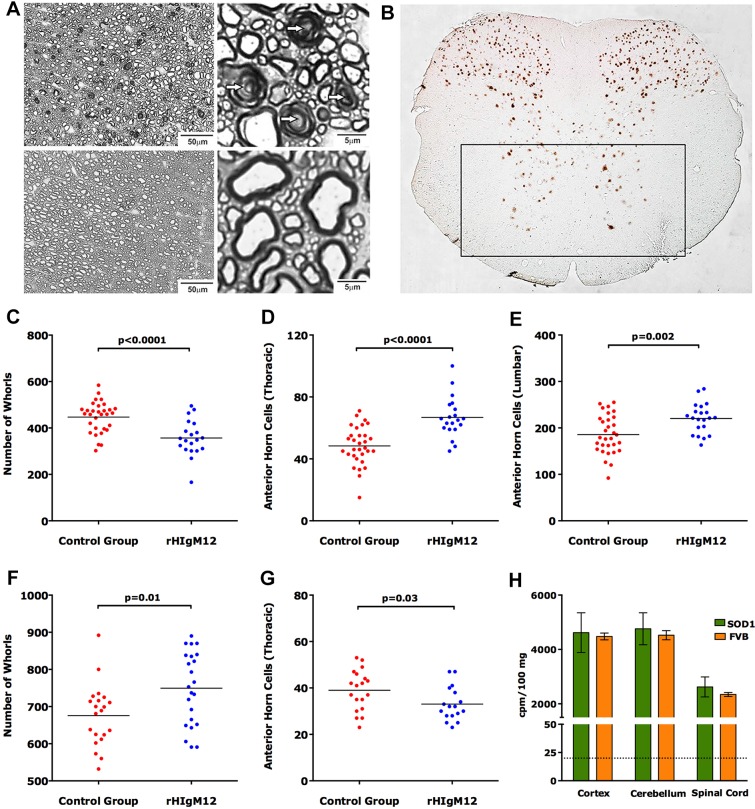
A single 200 µg dose of rHIgM12 preserves spinal cord neurons in SOD1G86R mice. Spinal cord axonal injury and motor neuron loss was examined histologically. Myelin whorls, characteristic of degenerating axons, were counted in six sampled areas from a mid-thoracic spinal cord section. (A) Representative mid-thoracic-level micrographs from a SOD1G86R mouse containing numerous myelin whorls (upper panels; arrows) compared to micrographs from an age-matched normal littermate control (lower panels). An analysis of the number of myelin whorls indicated fewer degenerating axons in rHIgM12-treated SOD1G86R mice compared to controls (C, P<0.0001, t-test). However, this was not true of rHIgM12-treated SOD1G93A mice (F, P=0.01). (B) Because human ALS primarily affects the health of motor neurons, anterior horn cells of the spinal cord (outlined in the black rectangle) were quantified across treatment groups. Two mid-thoracic- and two lumbar-level spinal-cord sections were stained with anti-NeuN, which nicely defines spinal-cord neuronal cell bodies. Anterior horn NeuN+ cells were counted in these four cross-sections. A larger number of NeuN+ cells were found at both the thoracic (D) and lumbar (E) levels in spinal cords of rHIgM12-treated SOD1G86R mice compared to controls (P<0.0001 and P=0.002, respectively, t-test). Again, this observation was not confirmed in thoracic-level sections from SOD1G93A mice (G). Each circle represents one animal. All tissue staining, imaging and analyses were performed blinded. (H) A single 50 µg intraperitoneal dose of rHIgM12 (10 million cpm of 35S) was administered to 90-day-old female SOD1G86R and FVB mice. 20 h later, cpm/100 µg of brain and spinal-cord tissue was determined. Bars are the mean±s.e.m. of three mice. Background counts for comparable weights of CNS tissue without rHIgM12 were 17-20 cpm (black dashed line).